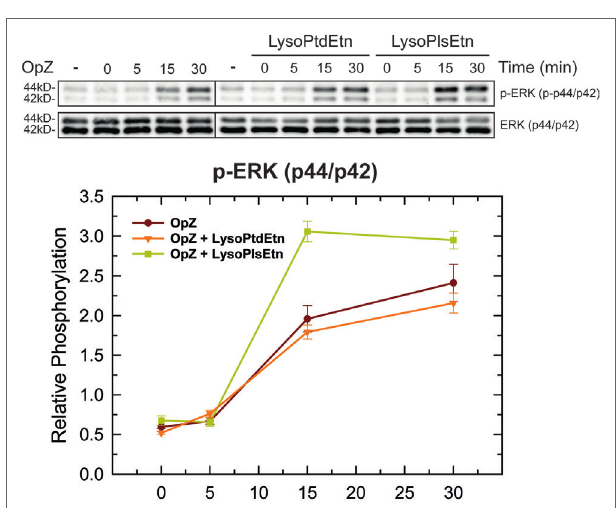
FigUre 8 | Effect of lysophospholipids on zymosan-induced signaling. RAW.108 cells were incubated with 10 µM lysoPtdEtn, 10 µM lysoPlsEtn or neither, as indicated, for 10 min. Afterward, the cells were stimulated with opsonized zymosan (OpZ) for the indicated times, and the phosphorylation of extracellular-regulated kinases (ERK) p44 and p42 was studied by immunoblot. The panel below the blots shows the relative quantification of p44 and p42 phosphorylation with respect to total ERK.